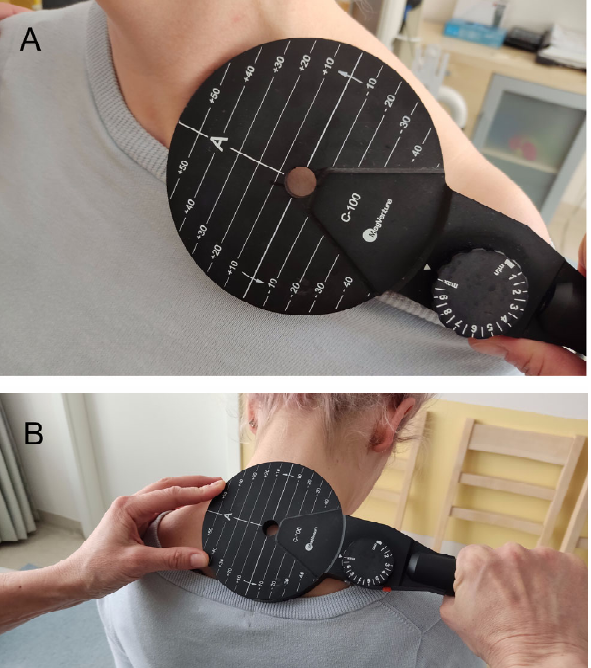
Figure 2. Photographs showing magnetic coil placement during MEP studies: ( A ) Erb’s point (level of brachial plexus trunks) stimulation and ( B ) stimulation over the vertebrae (level of cervical roots). The strength of the magnetic fi eld stream was 100% of the maximal stimulus output, which means 1.7 T for each pulse. The recordings were performed at an ampli fi cation of 20 mV/D and a time base of 5–8 ms/D. For the CMAP recording, a bipolar stimulation